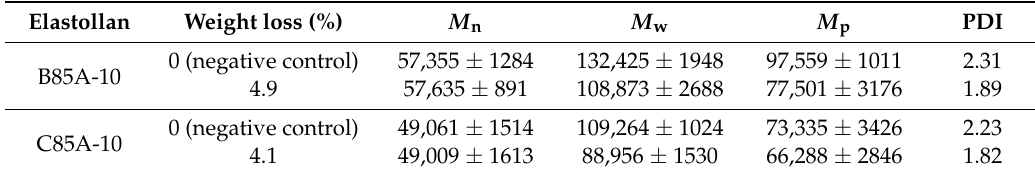
Table 3. Molecular weights of Elastollan B85A-10 and C85A-10 determined by GPC following hydrolysis by LCC at 70 ◦ C for 200 h and of negative control samples without enzyme. The polydispersity index (PDI) is the quotient of M w and M n